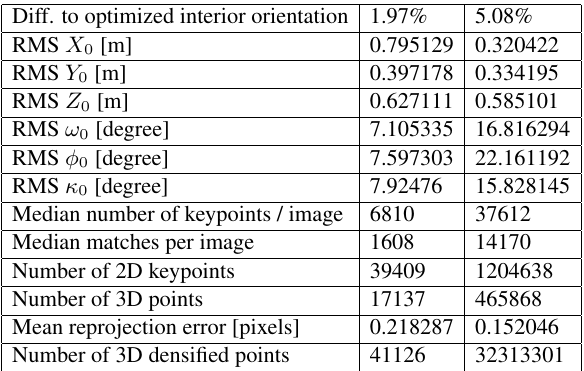
Table 1. Bundle block adjustment: The left column shows the results for the TIR image block, the right shows the results for the RGB image block. Interior orientation error, exterior orientation error (RMS), number of 2D and 3D points, their projection error and the total number of points of the point clouds Figure 2 shows the resulting dense point clouds for the TIR im- ages and the RGB images. It is obvious that the point density of